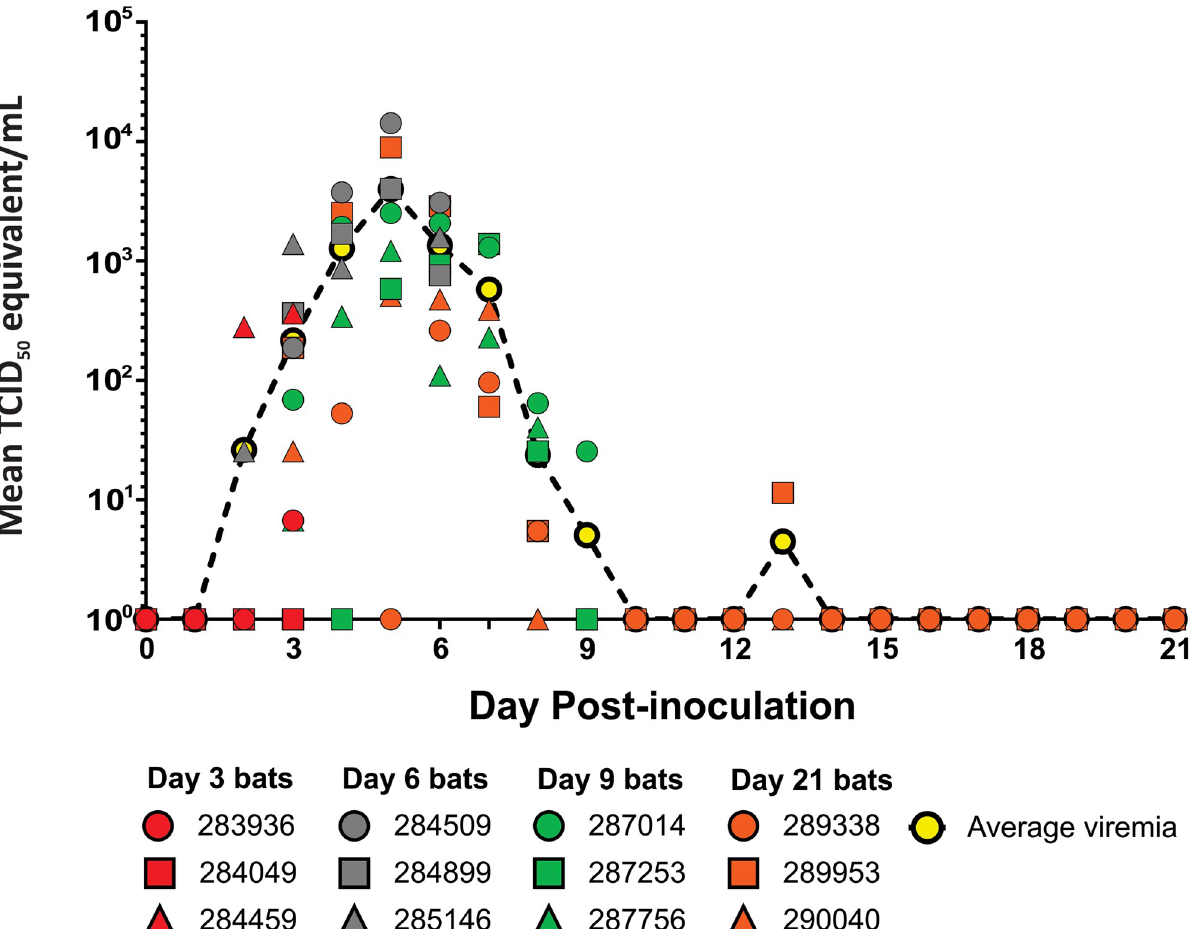
Fig 2. Sosuga virus RNA detected in blood of inoculated bats. Sosuga virus RNA levels in the blood (TCID 50 /mL equivalent) of individual bats that were sampled daily until their time of euthanasia. Individual bats are depicted by symbols (dot, square and triangle) and color-coded according to their day of euthanasia (red = day 3, gray = day 6, green = day 9, and orange = day 21). The total number of bats sampled according to days-post inoculation (DPI) were: 0–3 DPI = 12 bats, 4–6 DPI = 9 bats, 7–9 DPI = 6 bats, and 10–21 DPI = 3 bats. The mean viral RNA levels in the blood (TCID 50 /mL equivalent) for all bats according to DPI are shown as a dashed black line with yellow